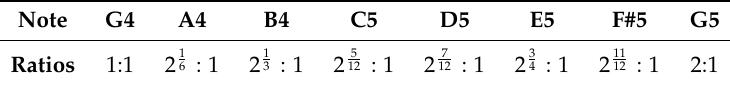
Table 3. One octave of the equal temperaments scale of G